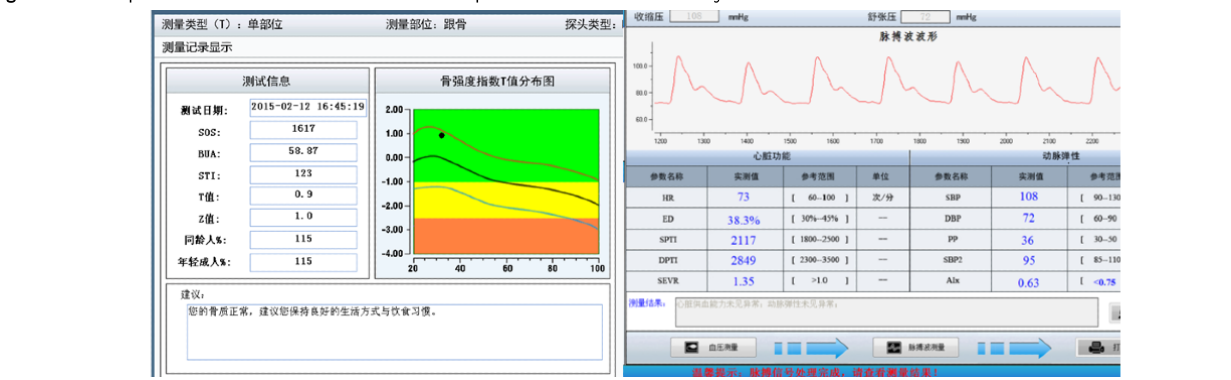
Figure 3. Examples of screenshots of the examination reports of bone mineral density and cardiovascular function.